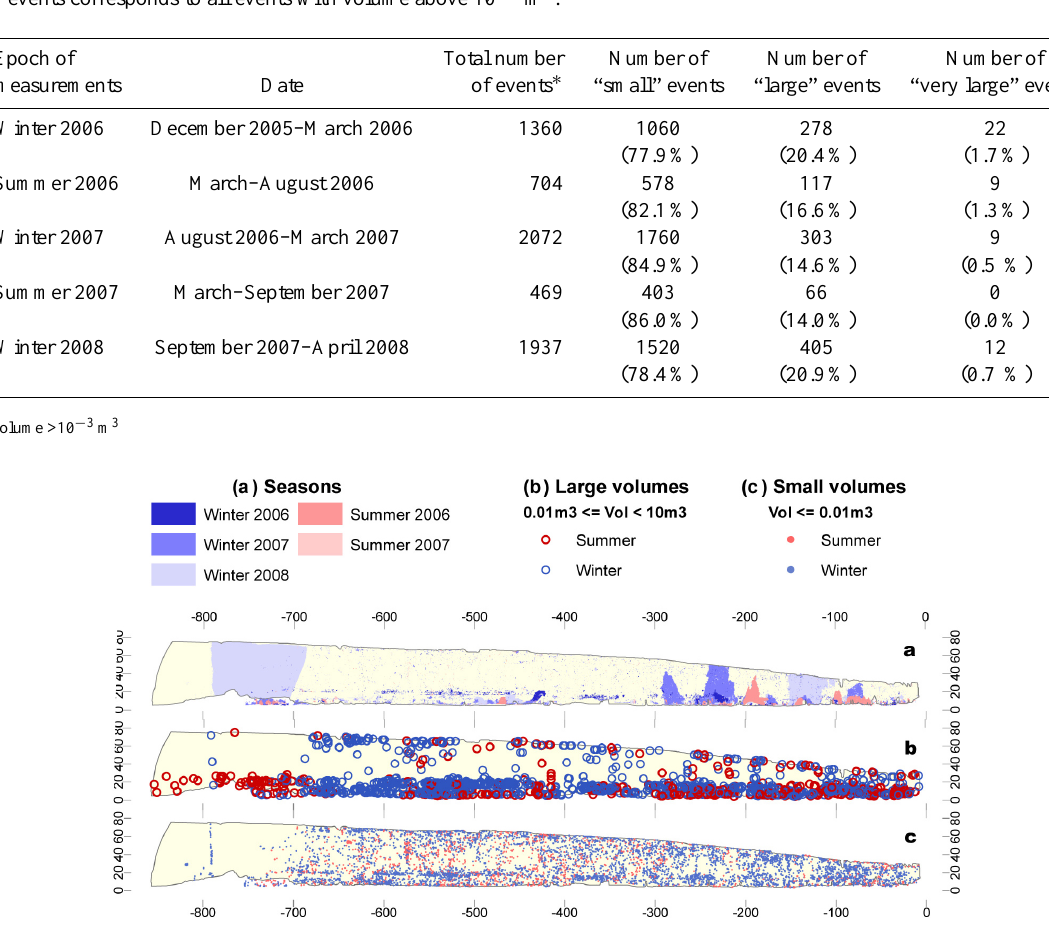
Figure 2. Spatial distribution considering the large and small events for all seasons (winters in blue and summers in red): (a) scars whatever their size; (b) centroids of the large volumes; (c) centroids of the small